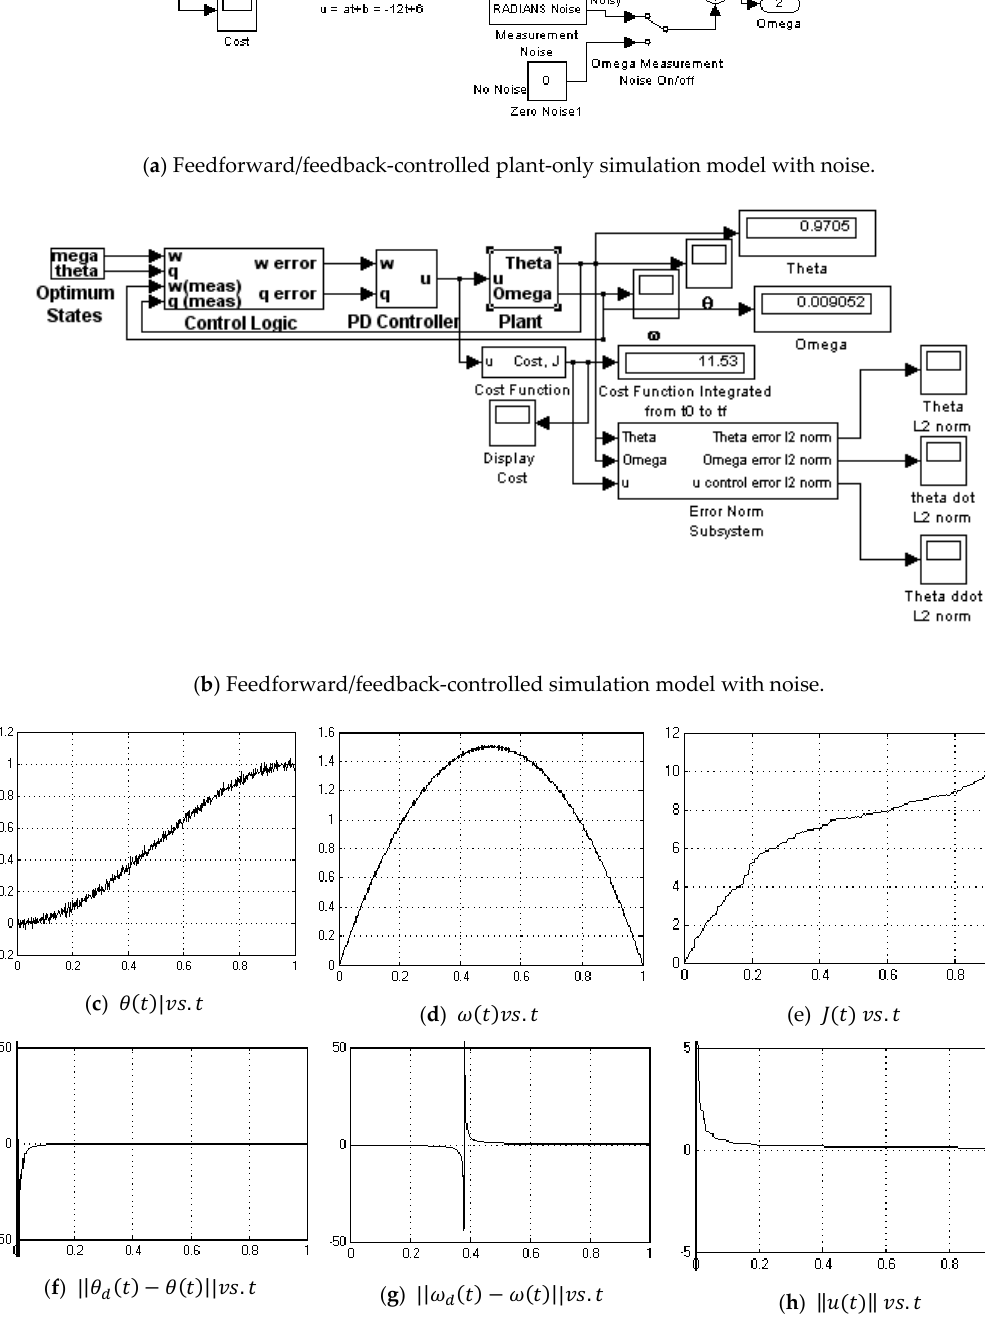
Figure A8. Feedforward/feedback PD controlled simulation with noise.